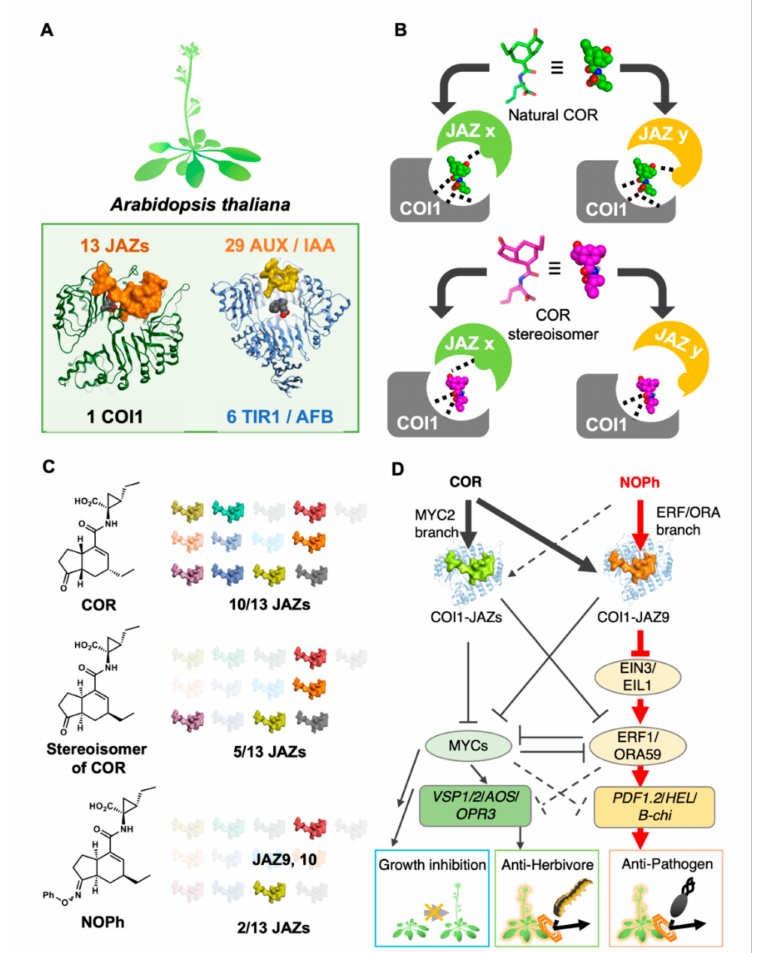
Figure 3. Stereochemistry-based tuning of JASMONATE ZIM-DOMAIN (JAZ) subtype selectivity. ( A ) Redundancy in plant hormone coreceptor complex; ( B ) schematic view of stereoisomer-based tuning of JAZ subtype selectivity; ( C ) observed JAZ subtype selectivity for one stereoisomer of COR and NOPh; and ( D ) overview of the mode of action of NOPh, a selective activation of ERF-ORA branch signaling pathway